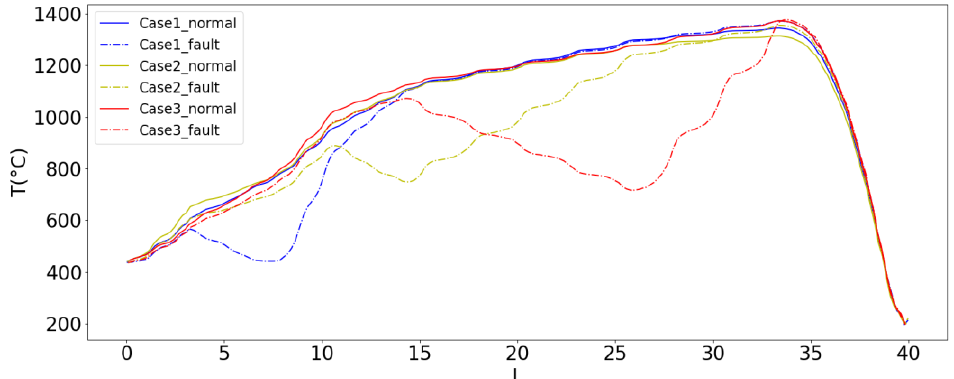
Figure 16. Temperature trend prediction results for three cases on fault data.